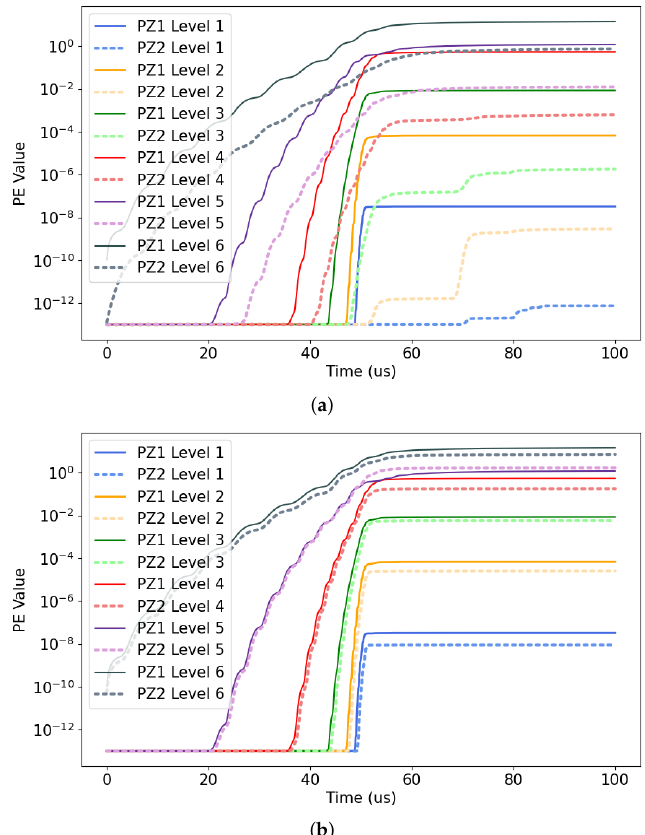
Figure 5. Average PE values for voltage TW per level by PZ and relay. ( a ) Measurements at R1 for faults in PZ1 compared to faults in PZ2. ( b ) Comparison of faults in relays’ next PZ. Measurements at R1 for faults in PZ1 compared to measurements at R2 for faults in